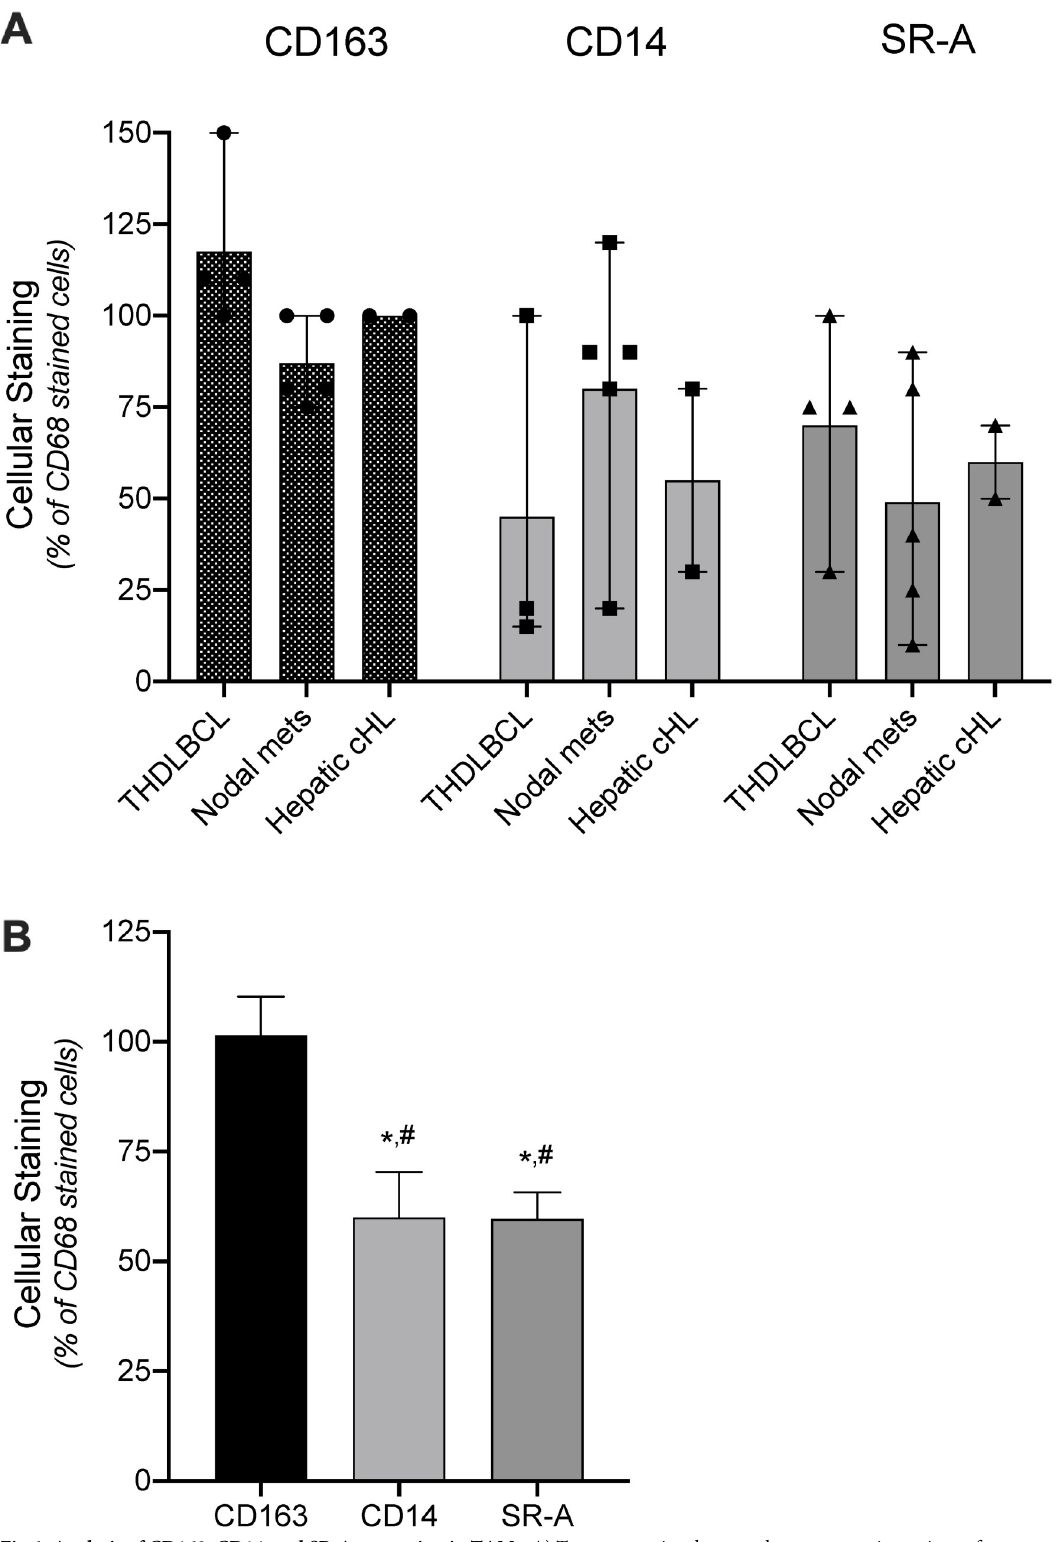
Fig 6. Analysis of CD163, CD14, and SR-A expression in TAMs. A) Tumor-associated macrophages present in sections of THRLBCL, metastatic colon cancer, and hepatic CHL were immunostained and scored for the percent of CD68 positive cells